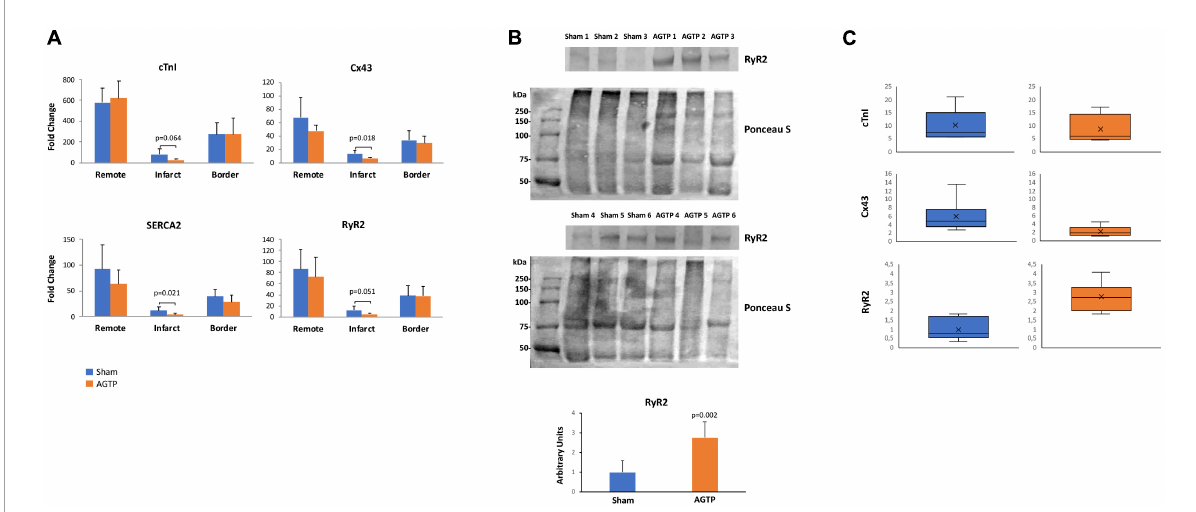
FIGURE6 Gene and protein expression profiles. (A) cTnI, Cx43, SERCA2 , and RyR2 gene expression in sham ( n = 7) and AGTP-treated ( n = 6) animals determined by normalizing the expression for each gene to GUSB following the 2 − (cid:49) Ct method. (B) Western Blot images of RyR2 presence and the respective Ponceau S staining to depict protein loading (top) and the corresponding histogram of RyR2 protein expression of sham and AGTP groups (bottom) . (C) cTnI, Cx43, and RyR2 protein expression determined by western blot in sham and AGTP-treated animals represented in